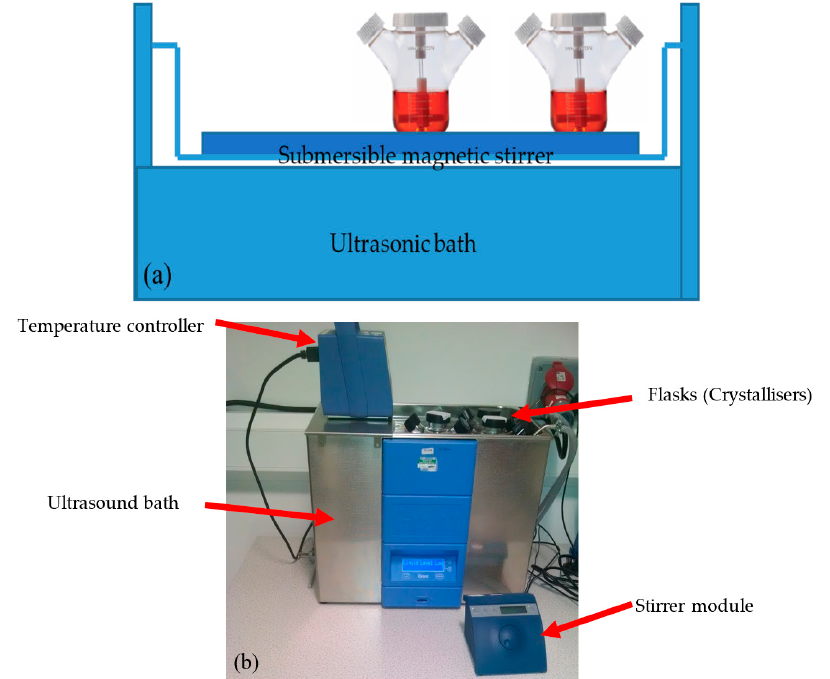
Figure 1. ( a ) Schematic diagram and ( b ) Annotated photograph showing the experiment setup for suspension cooling crystallisation of paracetamol in the presence of impurities using an ultrasonic